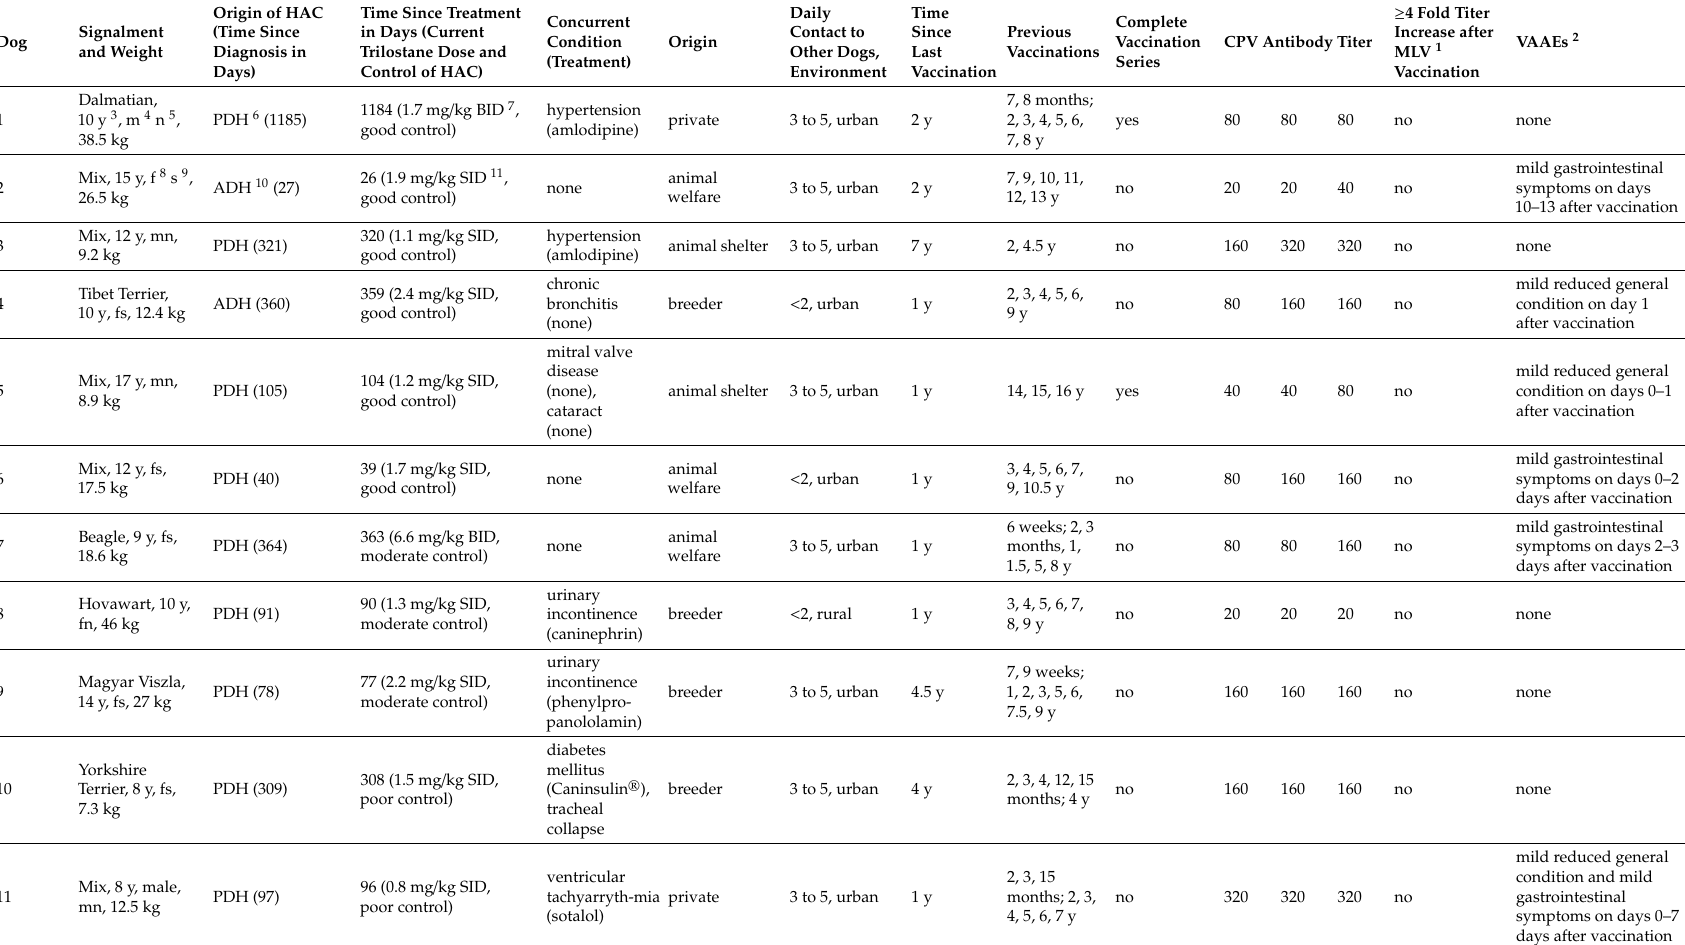
Table 1. Signalment, history, and pre-vaccination antibody titer against canine parvovirus (CPV) of the dogs with hyperadrenocorticism (HAC) treated with trilostane and their response to